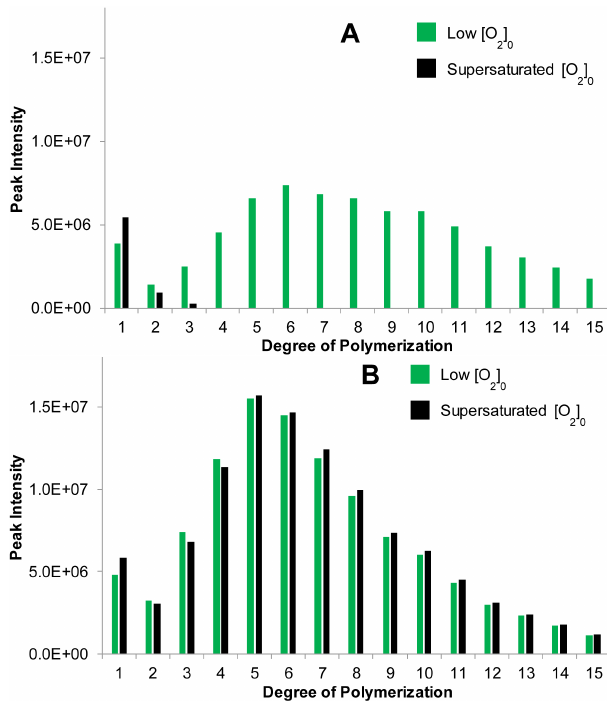
Fig. 8. Effect of initial O 2 concentrations on the oligomer series S174 up to 1200Da (obtained using UPLC-ESI-MS, for the re- tention time range 0–5min, in the positive mode) after (A) 5min and (B) 50min of OH-oxidation of MVK (20mM) in the aque- ous phase at 25 ◦ C, under initial low O 2 conditions (in green: [O 2 ] 0 = 60µM), and under initial supersaturated O 2 conditions (in black: [O 2 ] 0 = 400µM).